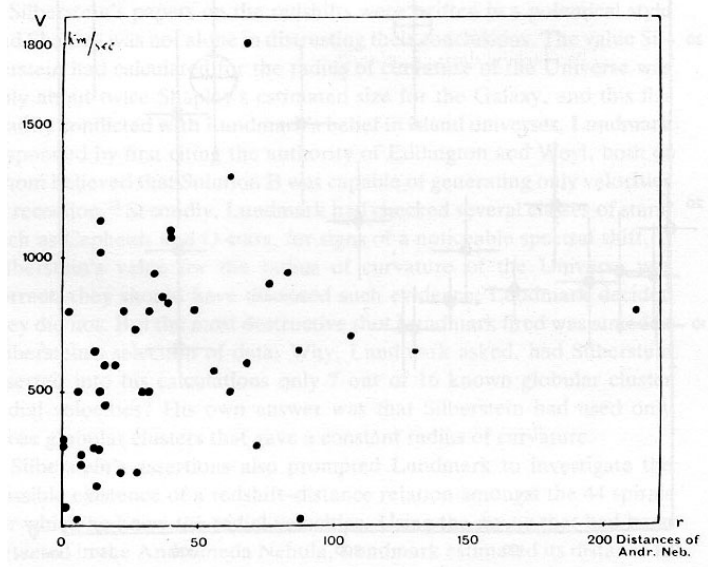
Figure 4. The first published cosmic velocity-distance diagram, Figure 4 . The first published cosmic velocity-distance diagram, 1924.